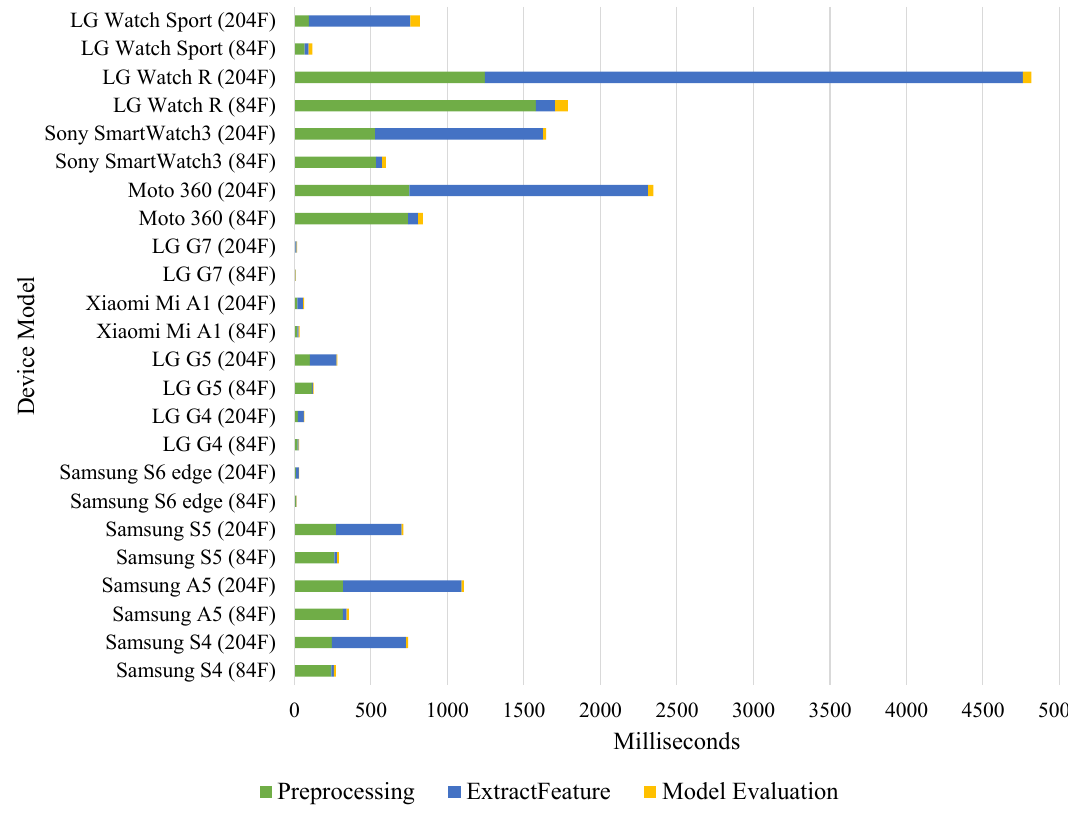
Figure 7. Processing time for 84 (84F) and 204 features (204F) extraction (lower is